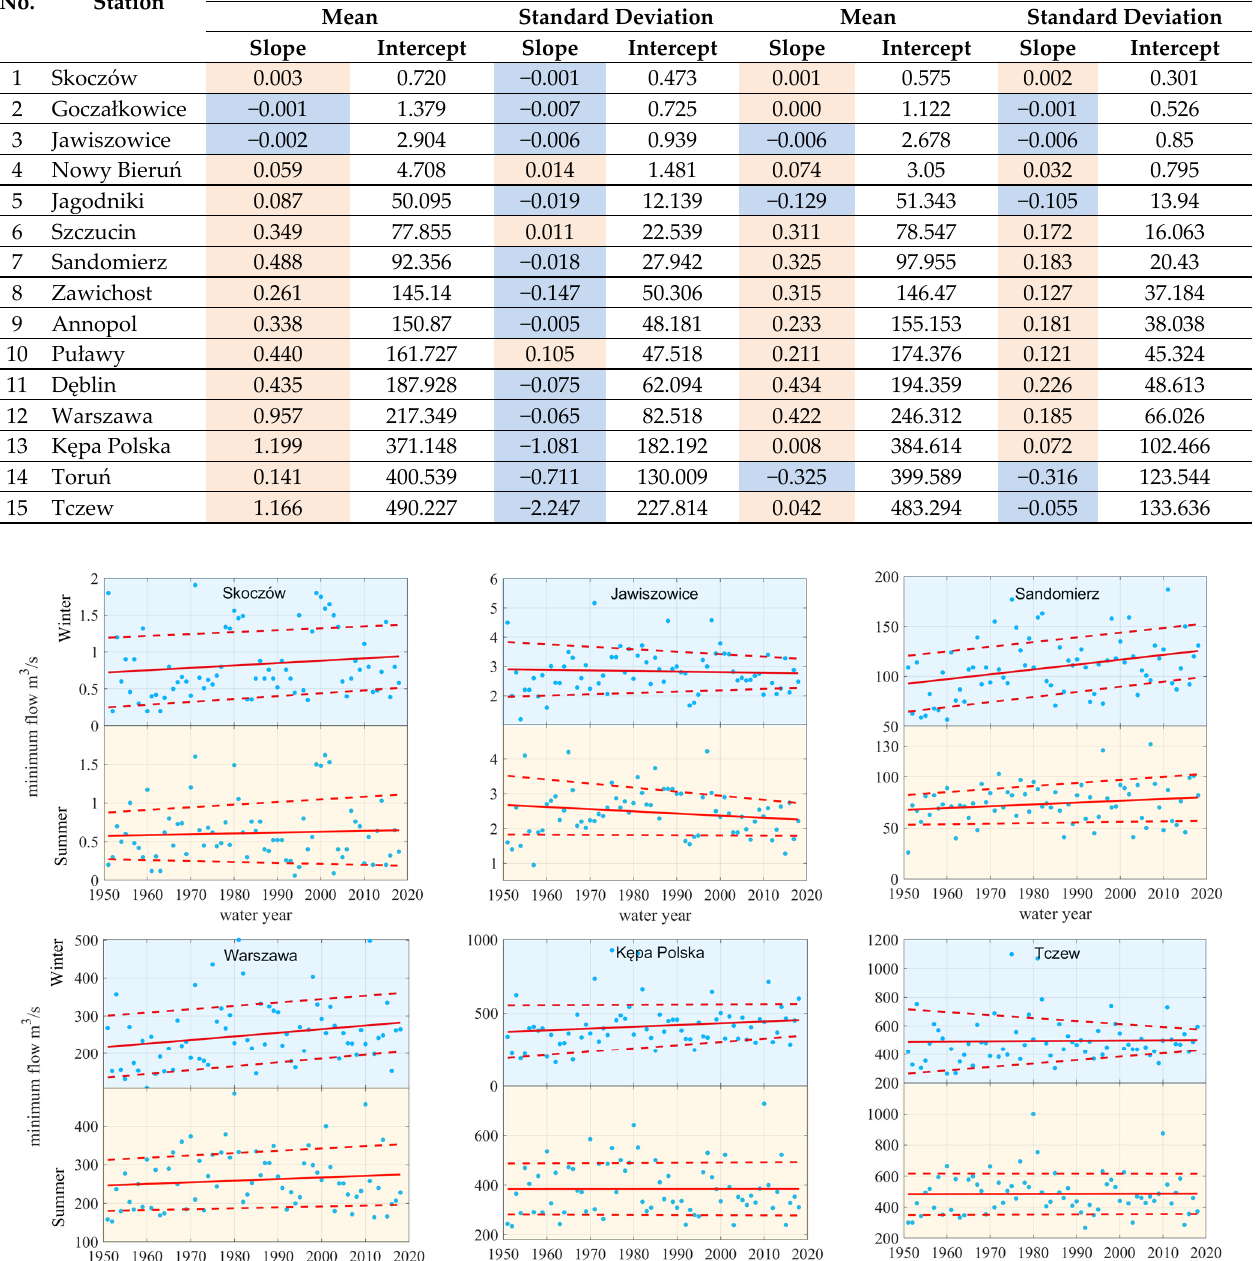
Figure 6. The linear trends in the mean and the standard deviation of seasonal instantaneous minima for selected stations along the Vistula.